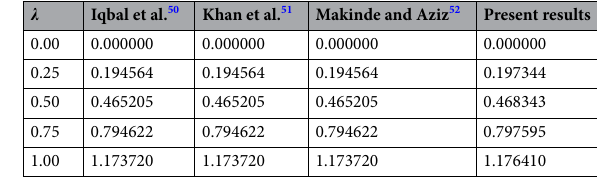
0 ) with previously reported results, when (cid:31) g ′′ (ξ − =